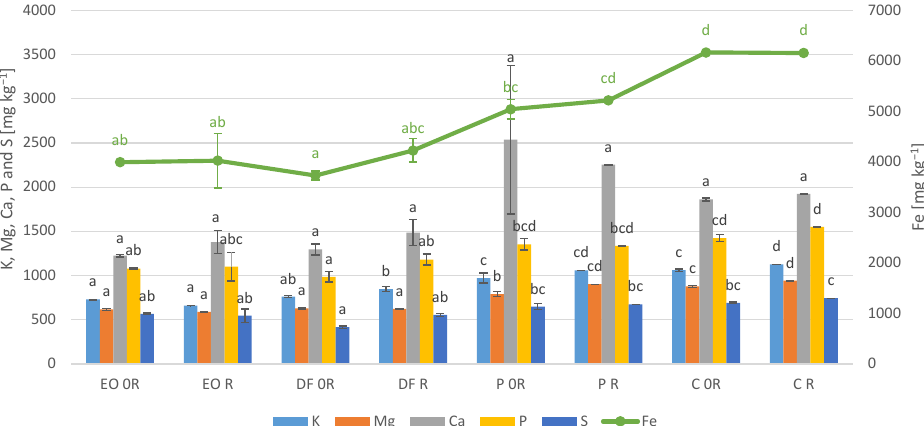
Figure 1. The effect of PDSs and bioremediation on the content of potassium, magnesium, calcium, phosphorus, sulfur and iron in the experimental soil (acid-extracted elements). The means ( ± SE) for individual elements that are marked with the same letters did not differ significantly according to Tukey’s test at p < 0.05. The symbols are the same as those in Table 3.